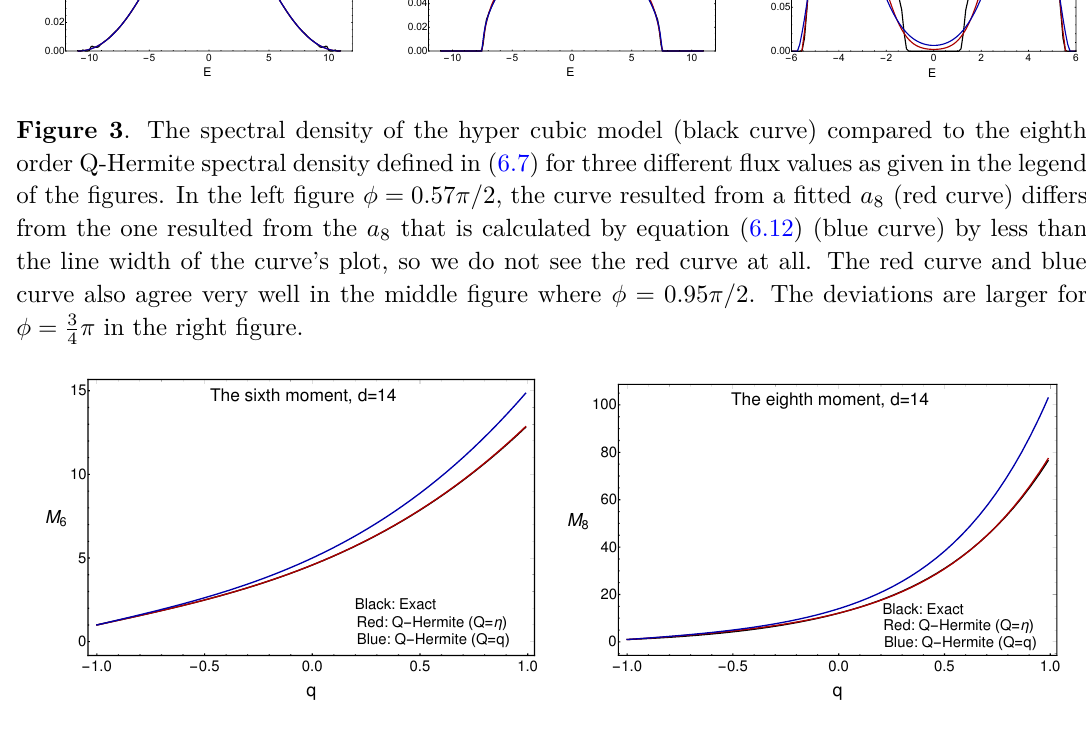
Figure 4 . The sixth (left) and the eighth (right) moments as functions of q at d = 14 . The exact results (black), the Q-Hermite (blue) results and the renormalized Q-Hermite (red) results are shown. We observe that renormalizing q to η greatly improves the accuracy at d = 14 . In fact, the renormalized results work so well that their curves can barely be distinguished from the exact